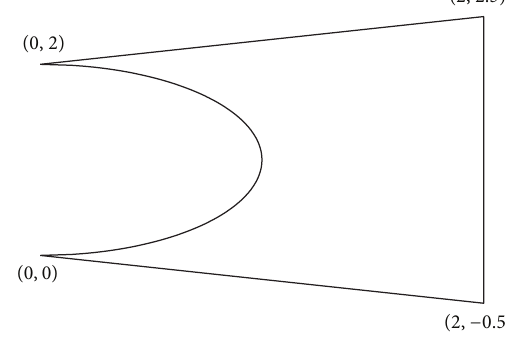
Figure 2: A curved